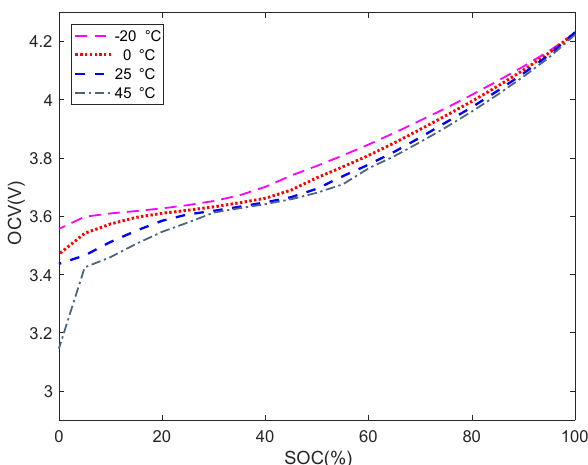
Figure 3. The battery OCV‐SOC relationship at different temperatures.